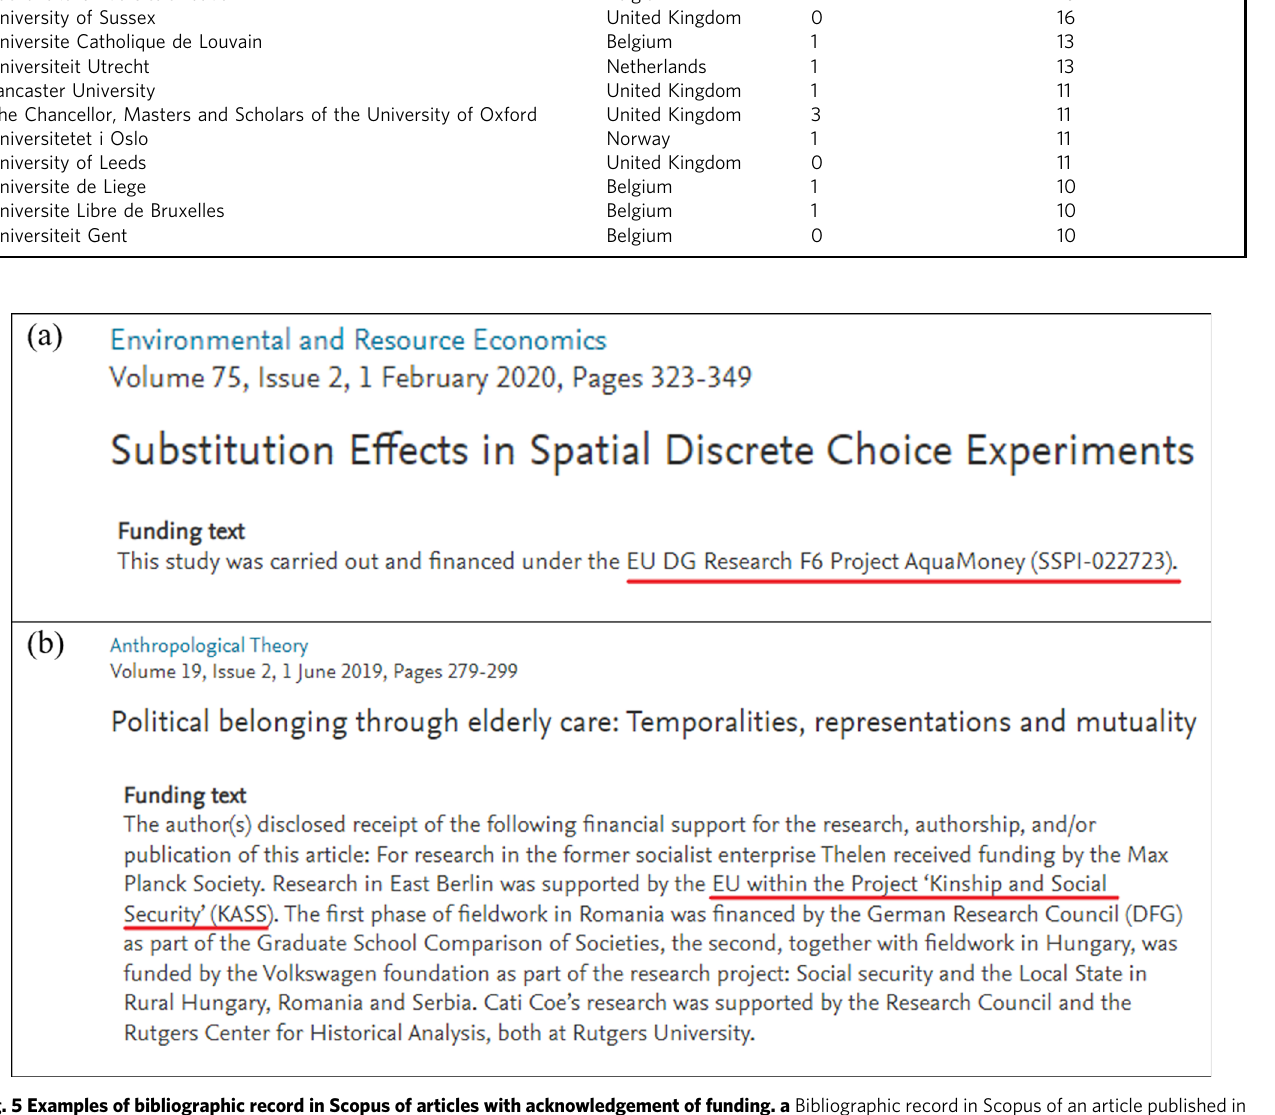
Fig. 5 Examples of bibliographic record in Scopus of articles with acknowledgement of funding. a Bibliographic record in Scopus of an article published